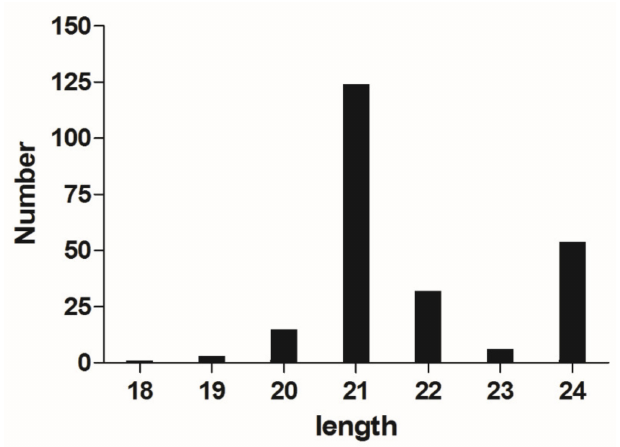
Figure 1. The length of miRNAs in the four